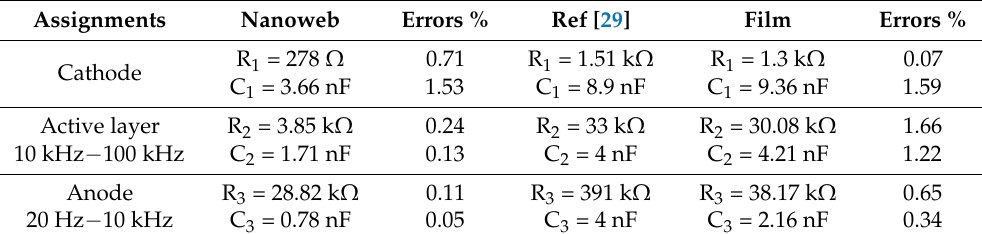
Table 1. Parameters of the equivalent circuit for the electrospun and neat film cathodes. Assignments